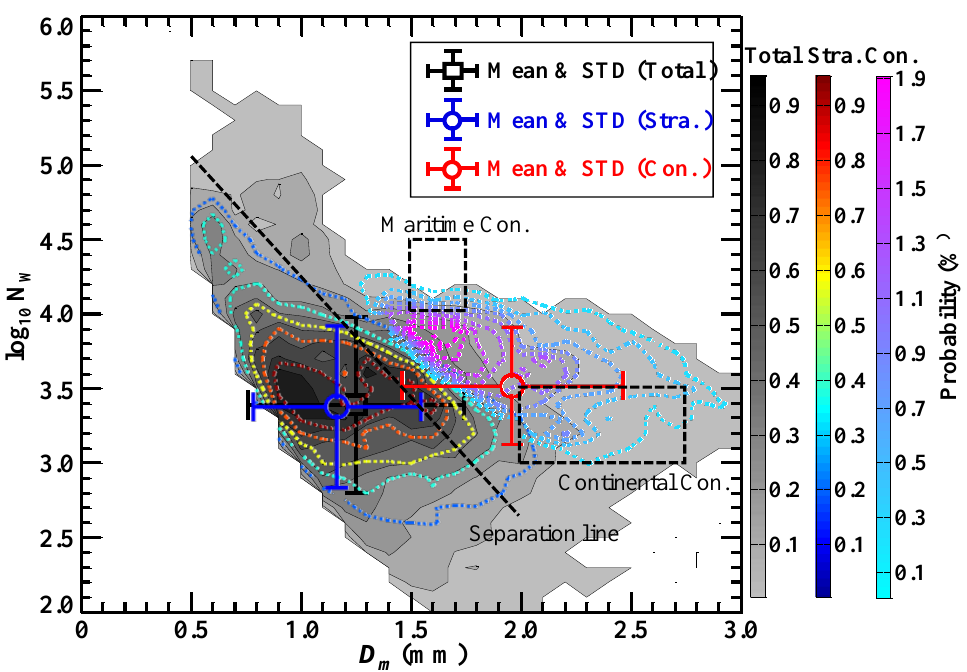
Figure 12. The probability distribution of D m and N w for the total precipitation samples (shaded), stratiform and convective precipitation samples (dotted contours). The square and circles denote means, and their connective short bars represent standard deviations. The thick dashed line and rectangles are the separation of two rain types and the ranges of the maritime and continental convections in Bringi et al. (2003) [27]. The unit of N w is m − 3 mm − 1 . The mean values of D m and log 10 N w for each precipitation type observed in various regions of China are summarized in Table 2. For stratiform precipitation, the mean D m of the CD area is comparable to that of the eastern Sichuan Basin [46], smaller than that of East and South China [43,57], and larger than that of North China, East TP, and Middle TP [13,22,38]. Meanwhile, the mean log 10 N w of the CD area is smaller than that of the other regions to different extents. For convective rains, the mean D m of the CD area is smaller than in south China and higher than in the other five regions. Mean log 10 N w in the CD area has a similar value to Mid-TP, whereas it is slightly larger than in East TP and much smaller than in the other four regions. Table 2. Mean values of D m and log 10 N w for each precipitation type observed in various regions of China. The unit of N w is m − 3 mm − 1